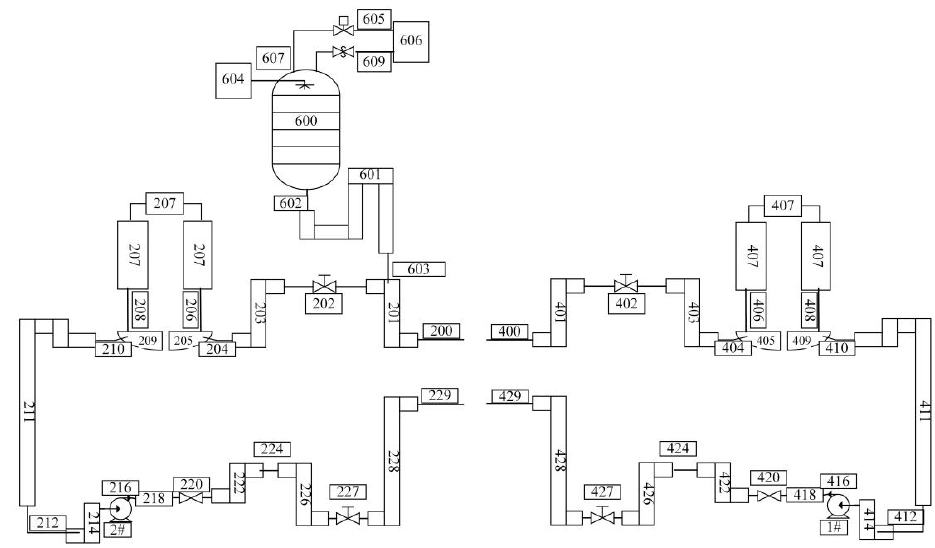
Figure 1. Analysis model of coolant system.